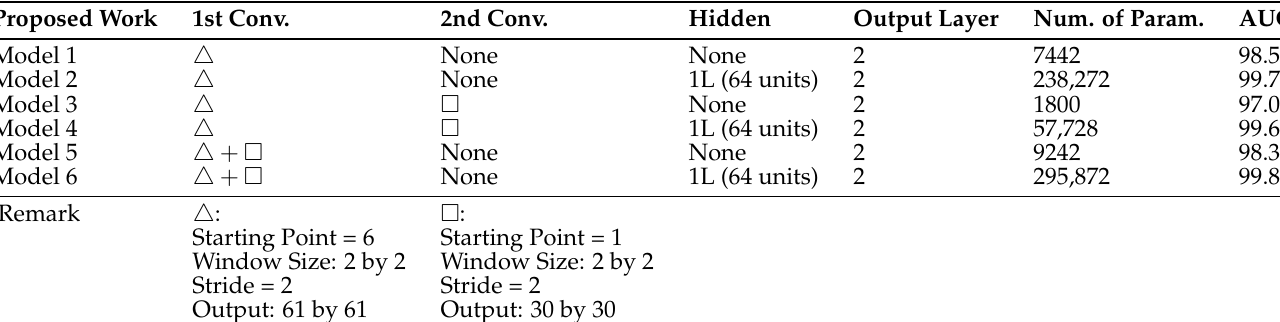
Table 10. A summary of the statistics of the design of the proposed network: interaction-based convolutional neural network (ICNN), for Models 1–6. Each model can take one or two interaction-based convolutional layers (i.e., 1st Conv. or 2nd Conv. Layer). The model can be designed to directly proceed from the interaction-based convolutional layer to the output layer. For example, Models 1 and 3 proceed directly from the convolutional layer to the output layer, i.e., no hidden layer. Proposed Work 1st Conv. 2nd Conv. Hidden Num. of